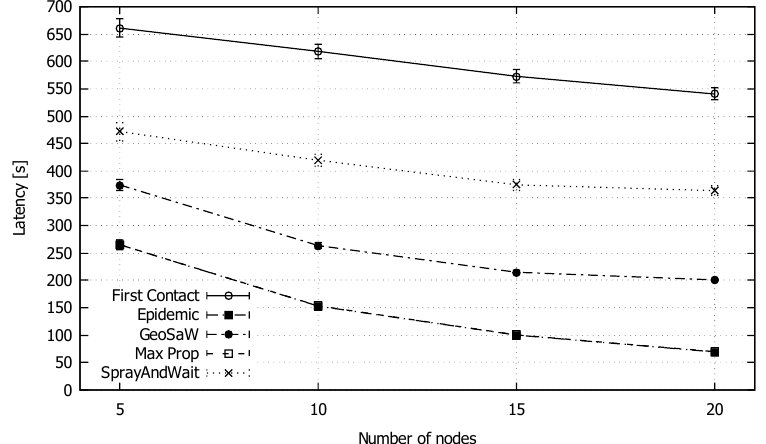
Figure 6. Average latency of GeoSaW compared with other DTN routing protocols when varying the number of